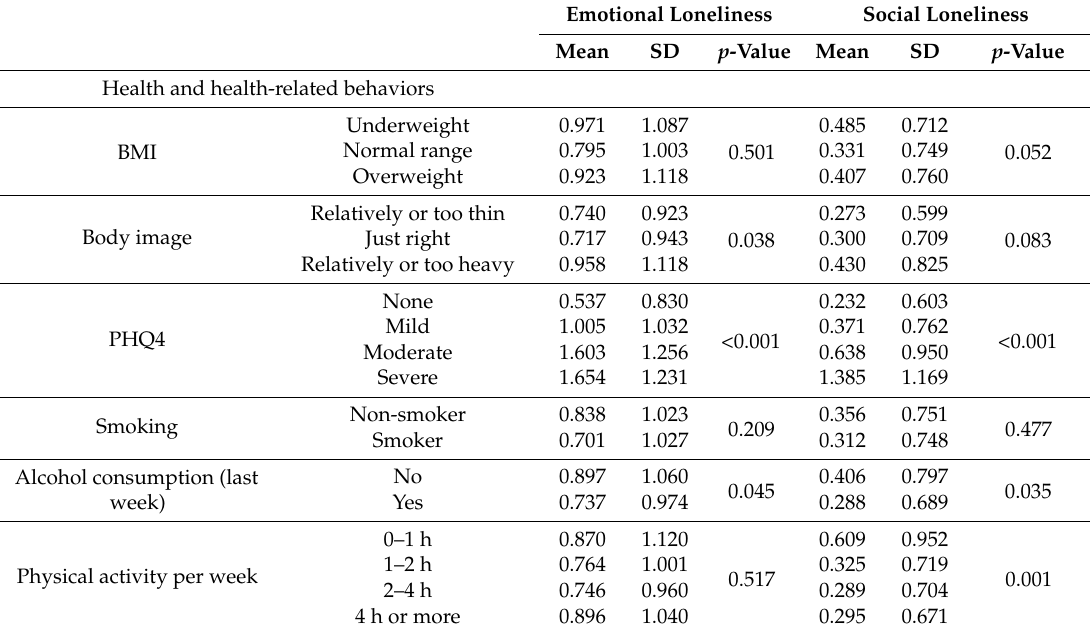
Table 3. Emotional and social loneliness by health and health-related behaviors in university students in Germany.